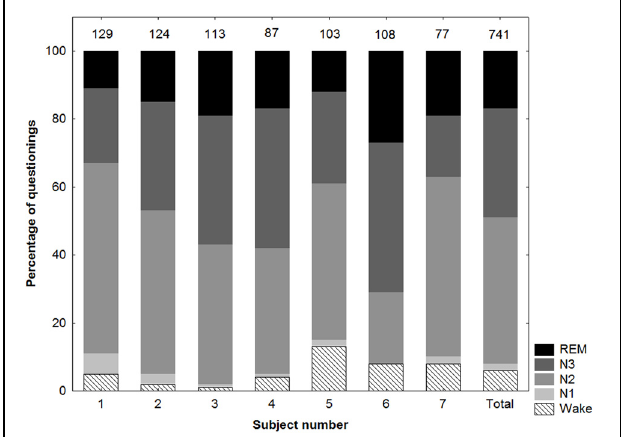
questionings per subject.